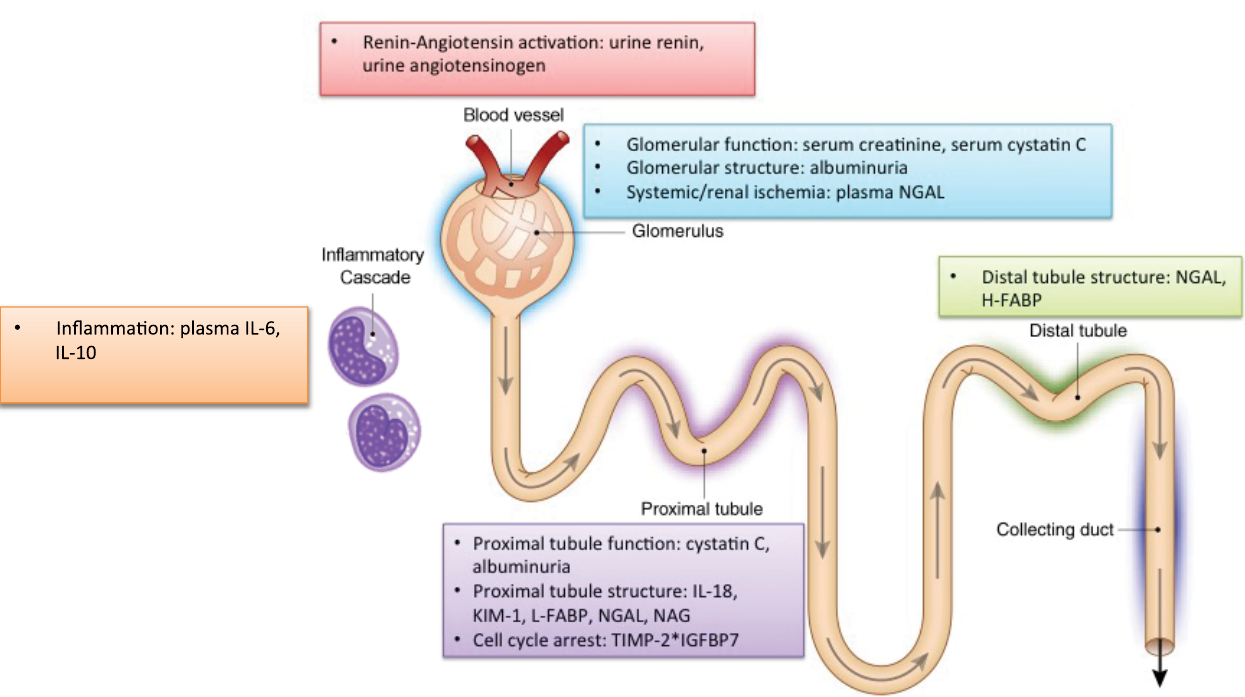
Figure 1. Physiology of biomarkers of AKI. Adapted from 73. AKI, acute kidney injury; H-FABP, heart fatty acid binding protein; IGFBP-7, insulin-like growth factor binding protein 7; IL-6, interleukin-6; IL-10, interleukin-10; IL-18, interleukin-18; KIM-1, kidney injury molecule-1; L-FABP, liver fatty acid binding protein; NAG, N-acetyl- β -D-glucosaminidase; NGAL, neutrophil gelatinase-associated lipocalin; TIMP-2, tissue inhibitor